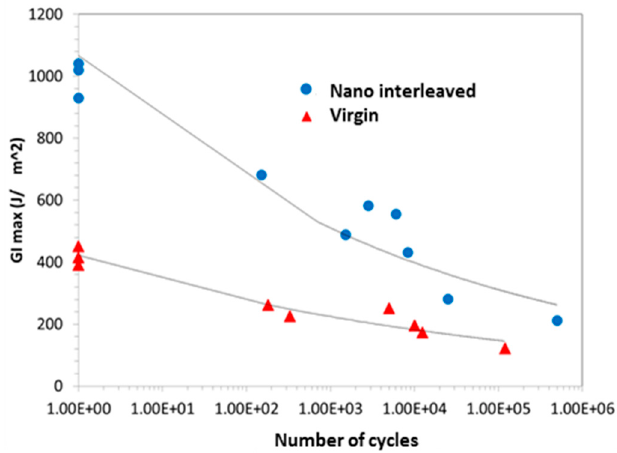
Figure 3. Load–displacement curves of the static tests.